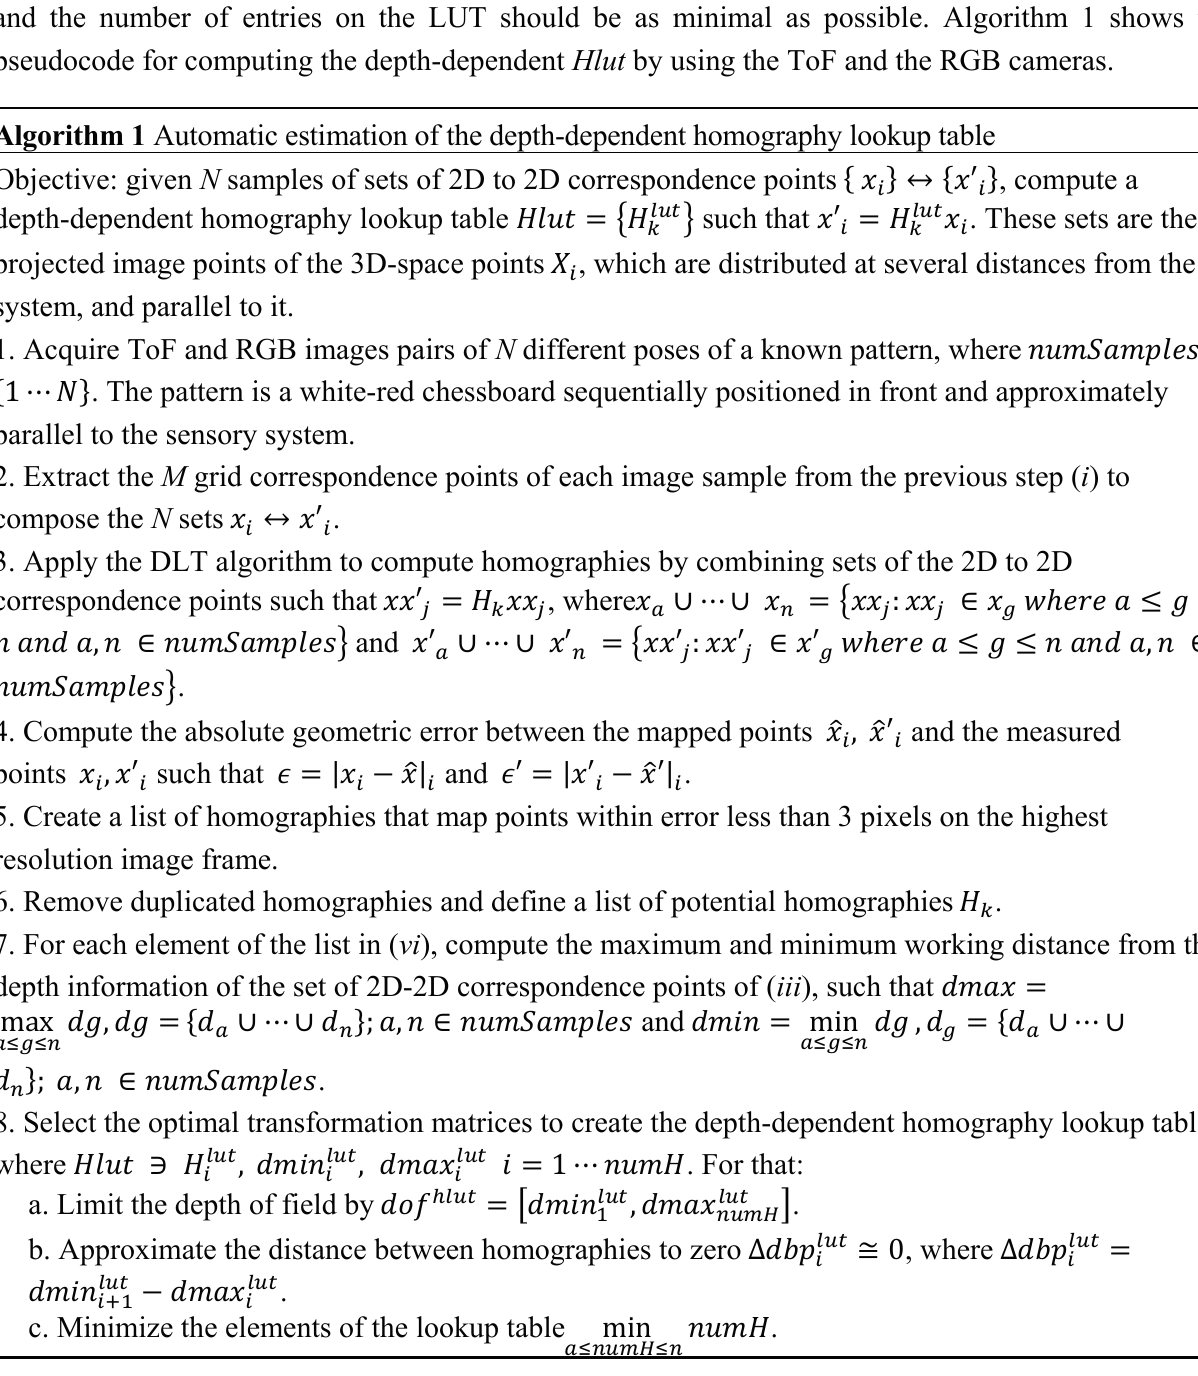
Algorithm 1 Automatic estimation of the depth-dependent homography lookup